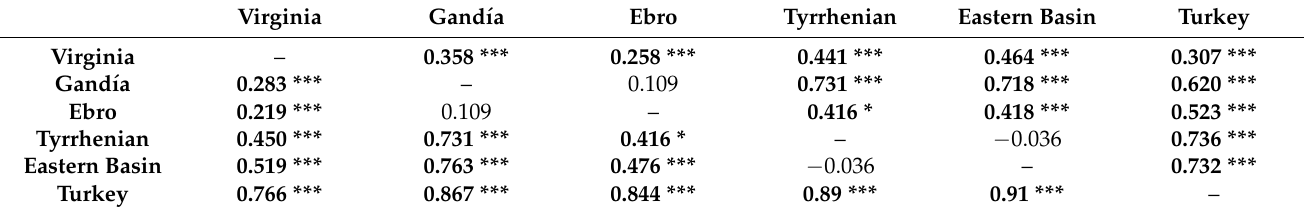
Table 3. Pairwise comparisons of genetic differentiation, in European populations of Callinectes sapidus , estimated from nucleotide divergence ( Φ ST , below the diagonal) and haplotype frequency ( F ST , above the diagonal). Significant values in bold (*: p < 0.05; ***: p < 0.001) were calculated from 10,000 permutations. Virginia N = 18, Gand í a N = 20, Ebro N = 19, Tyrrhenian N = 10, Eastern Basin N = 18, Turkey N =